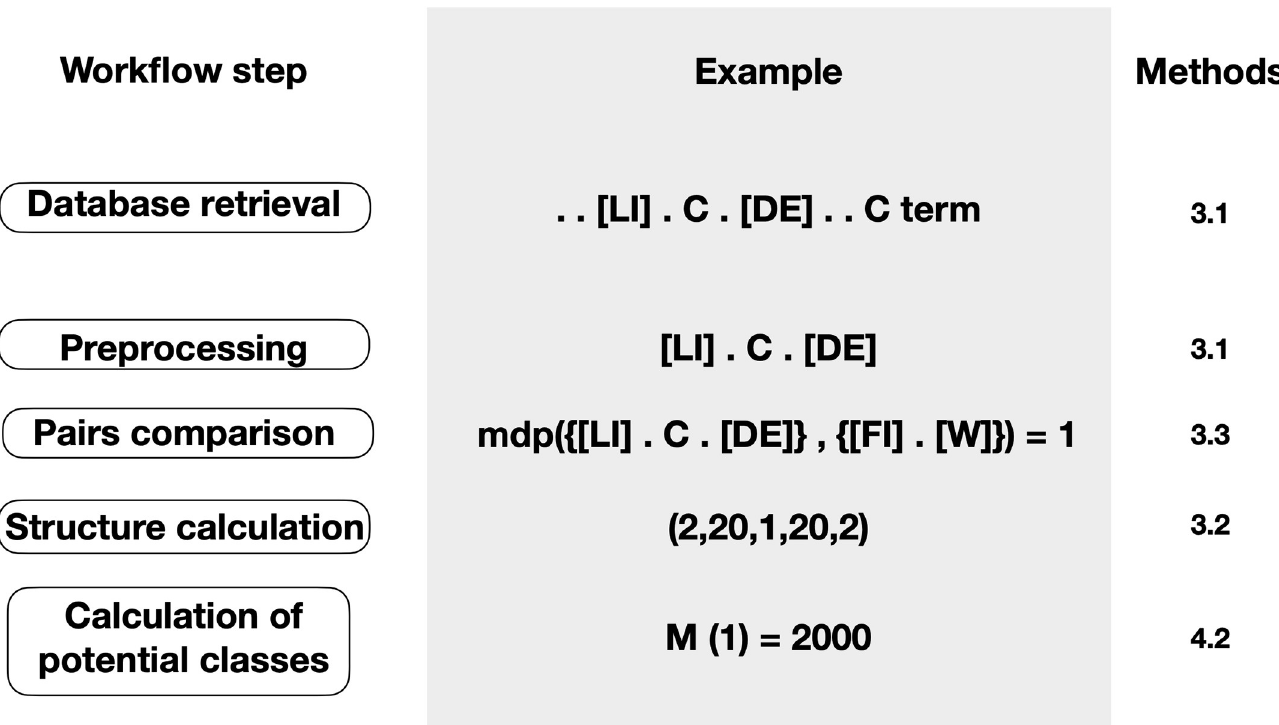
Fig 2. Workflow description. Process from the raw data for motif classes found in ELM db to the calculation of the potential number of motif classes.